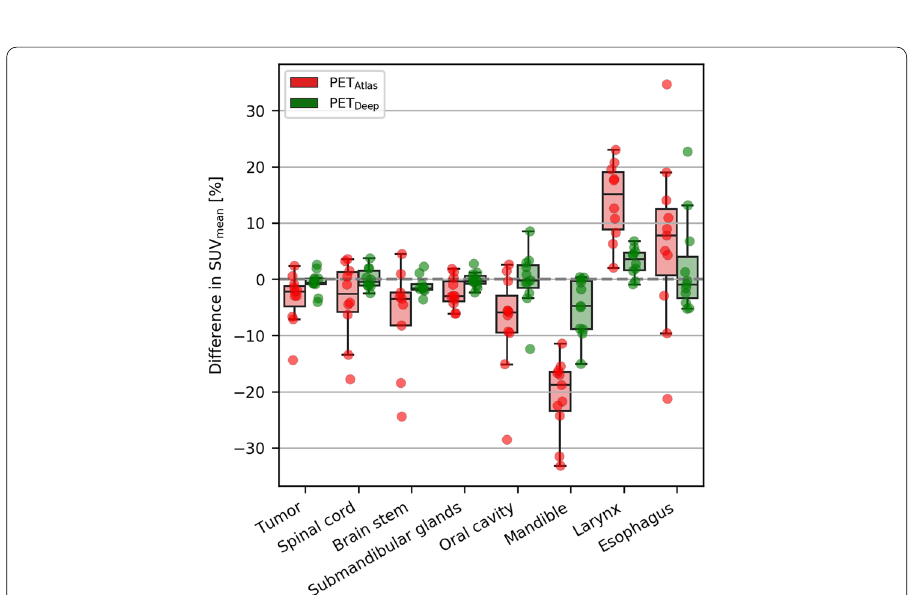
Fig. 5 Regional analysis showing box-whiskers plots (box shows the quartiles of the data; whiskers show the 1.5 times interquartile range of the data) of the errors in SUV mean within different anatomical regions and the tumors. The individual errors are shown as colored dots on top of the